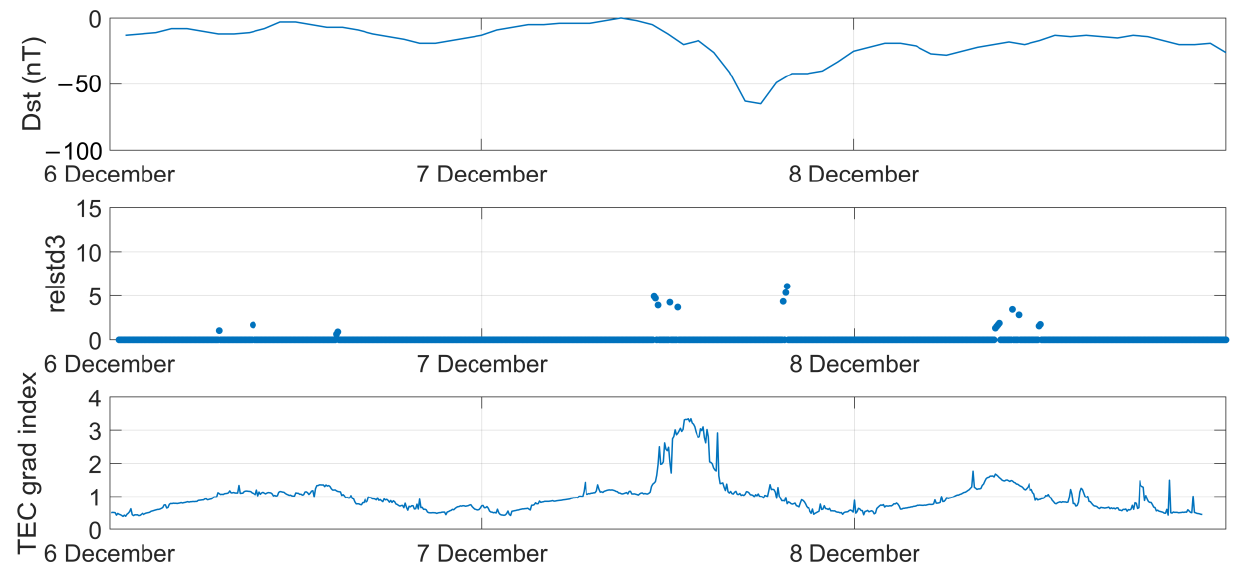
Figure 18. The Dst index ( top panel ), the relstd3 values obtained for the Dourbes location ( middle panel ), and the TEC gradient index ( bottom panel ) for the time interval 6–8 December 2022.